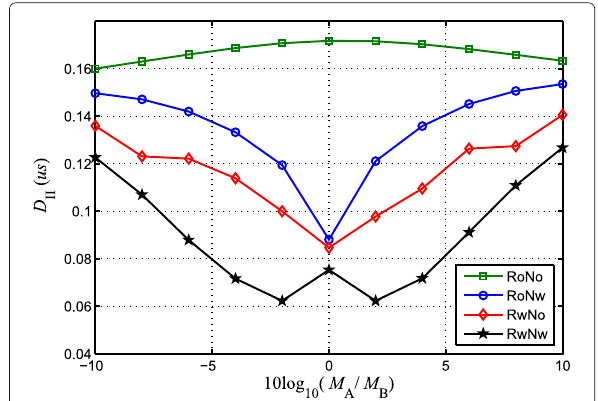
Fig. 8 D Tot performance comparison of the four schemes in Example 1, where h A = [6 6 5 5 4 3 2 2 1] and h B = [6 6 6 5 4 4 3 2 1 1]